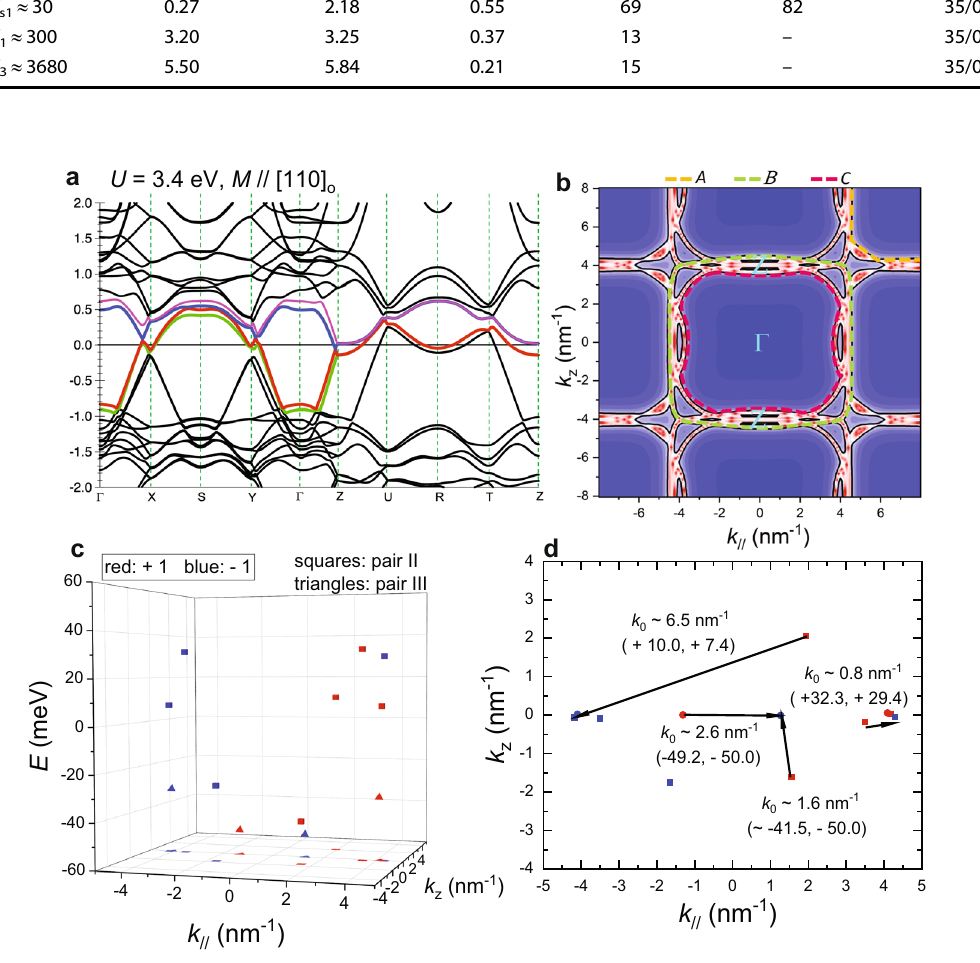
Fig. 4 Electronic structures calculated by DFT + U with U = 3.4 eV and J = 0.68 eV for the orthorhombic SRO. a Band structure near the Fermi energy calculated with spin – orbit coupling in the ferromagnetic ground state with the magnetic moment oriented along [110]